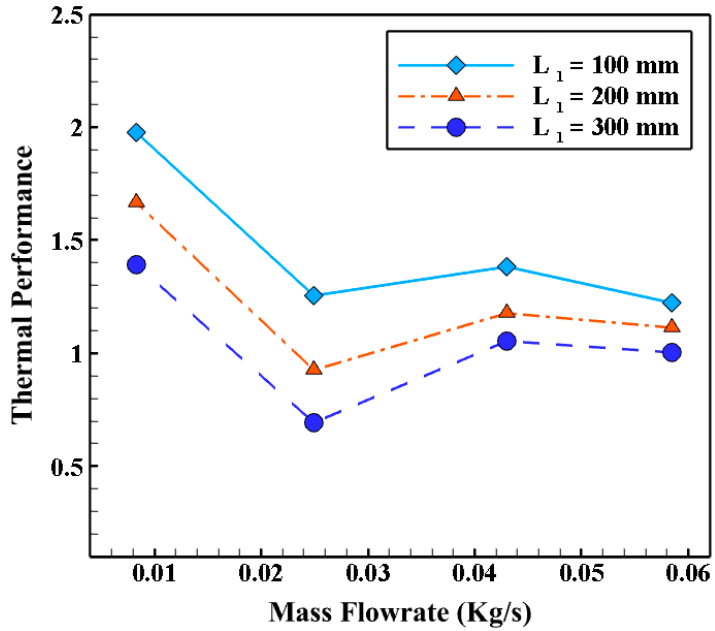
Figure 12. The deviations of thermal performance versus the mass flow rates for various lengths of swirl generator at n = 12, θ = 180 degrees, and S = 0.3 π mm.